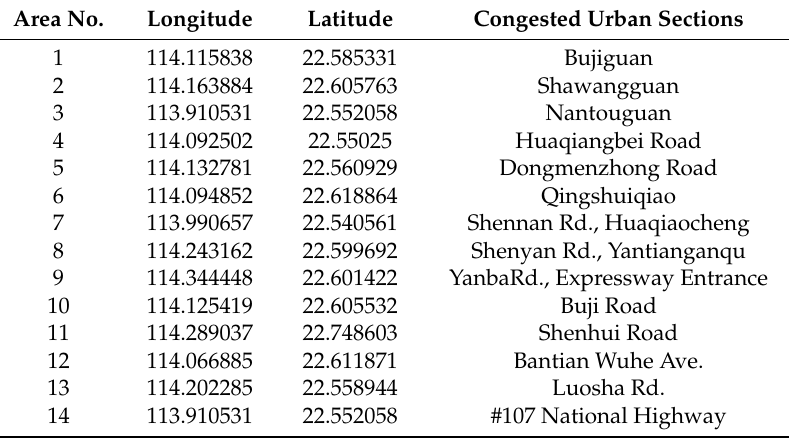
Table 14. Central points of congested areas.